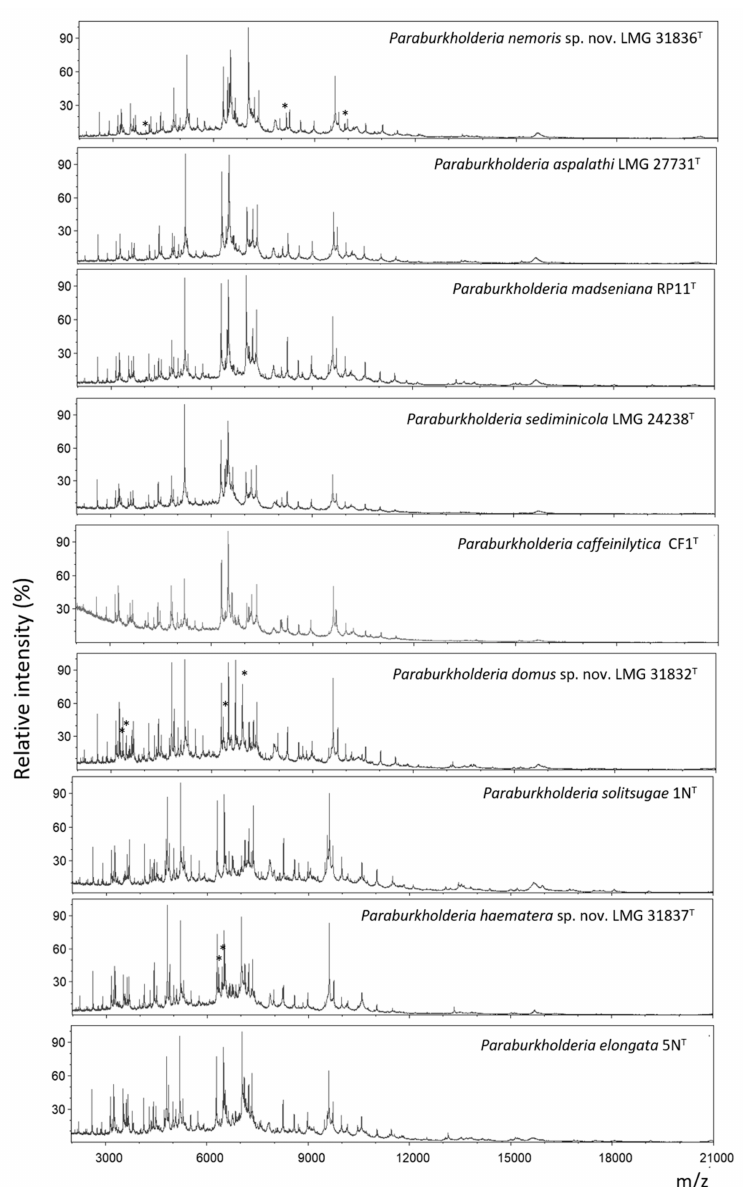
Figure 4. MALDI-TOF MS profiles of strains LMG 31832 T , LMG 31836 T , LMG 31837 T and their closest phylogenetic neighbor type strains, ordered conform to genomic relatedness. Asterisks indicate peaks that allow differentiation of the strain from its closest